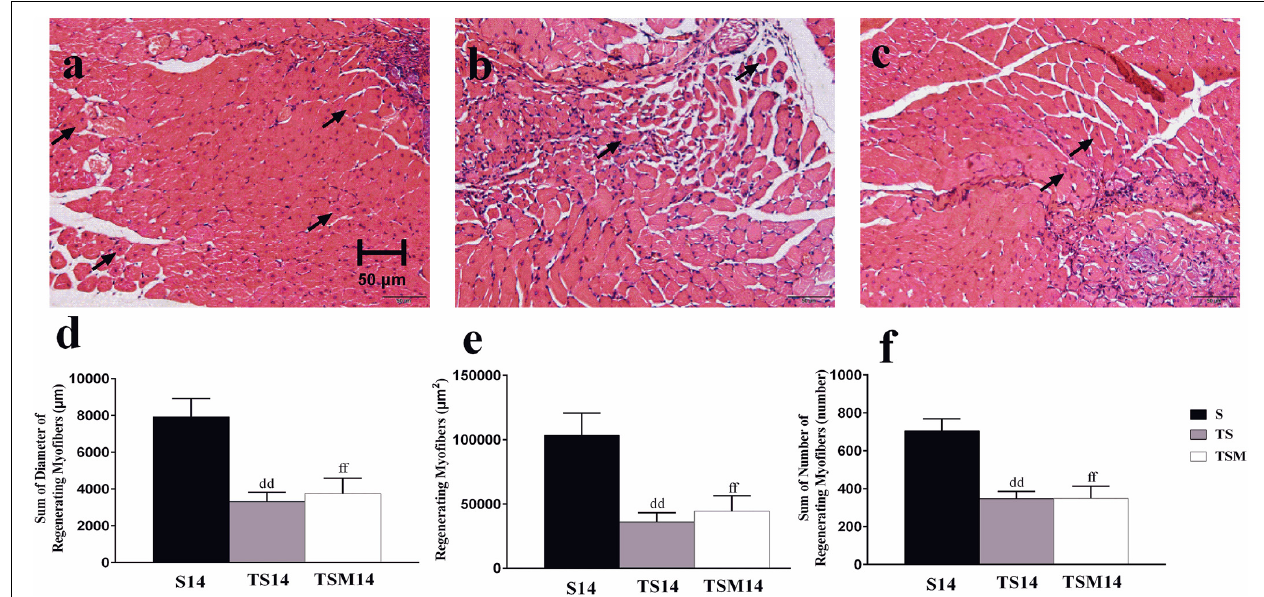
FIGURE 3 | Effects of MGF injection on muscle regeneration after macrophage depletion at 14 days post-injury. (a) Muscle contusion group (14 days post-injury); (b) muscle contusion and macrophage depleted group (14 days post-injury); (c) muscle contusion, macrophage depleted, and MGF treated group (14 days post-injury); (d) quantification of the diameter of regenerating myofibers in GMs; (e) quantification of the area of regenerating myofibers in GMs; (f) quantification of the number of regenerating myofibers in GMs; Data are means ± SEM, n = 4. dd Significant difference from S14, p < 0.01; ff Significant difference from S14, p < 0.01. Scale bars = 50 µ m. regenerating